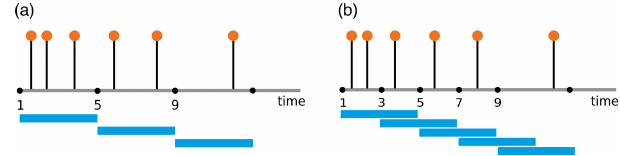
Figure 1. (a) Non-overlapping windows of window size 4; (b) over- lapping windows with 25% sharing.